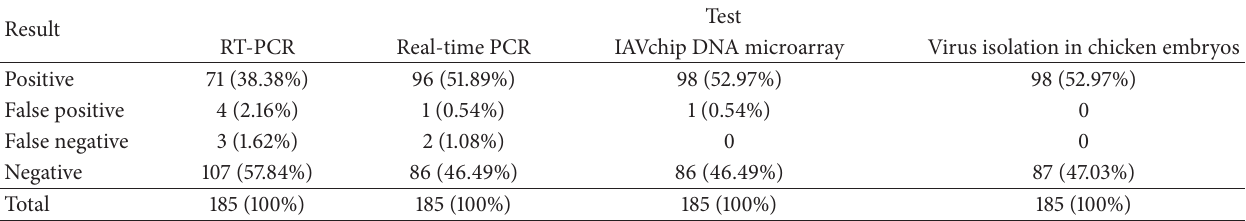
Table 3: Comparison of the results of our test using IAVchip DNA-microarray with the results of real-time RT-PCR and RT-PCR.